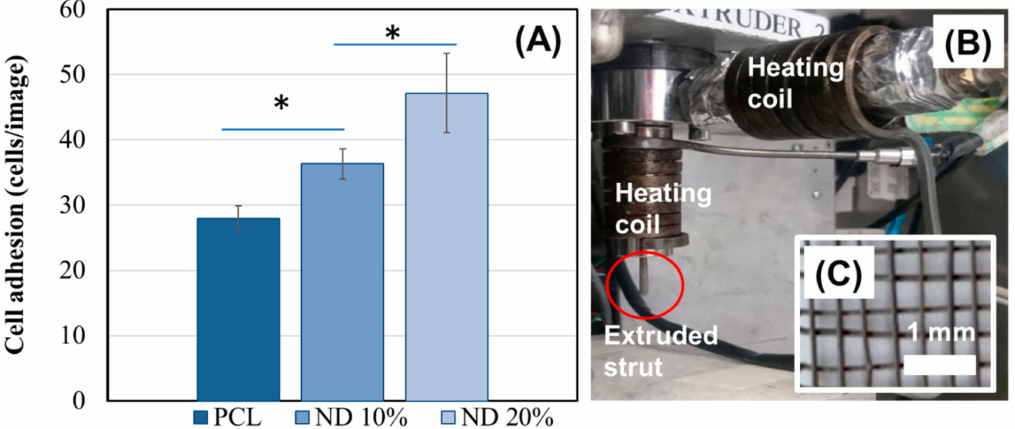
Figure 3. ( A ) Osteoblast adhesion on composite materials showing higher adhesion compared to PCL alone (mean ± S.E.M, n = 6, student t -test ( p ≤ 0.05)). ( B ) Proof of concept of the 3D printing compatibility of PCL-ND 20% composite showing the melt-extrusion setup and ( C ) a sca ff old printed using layer-by-layer deposition of extruded struts (nozzle size: 20-gauge